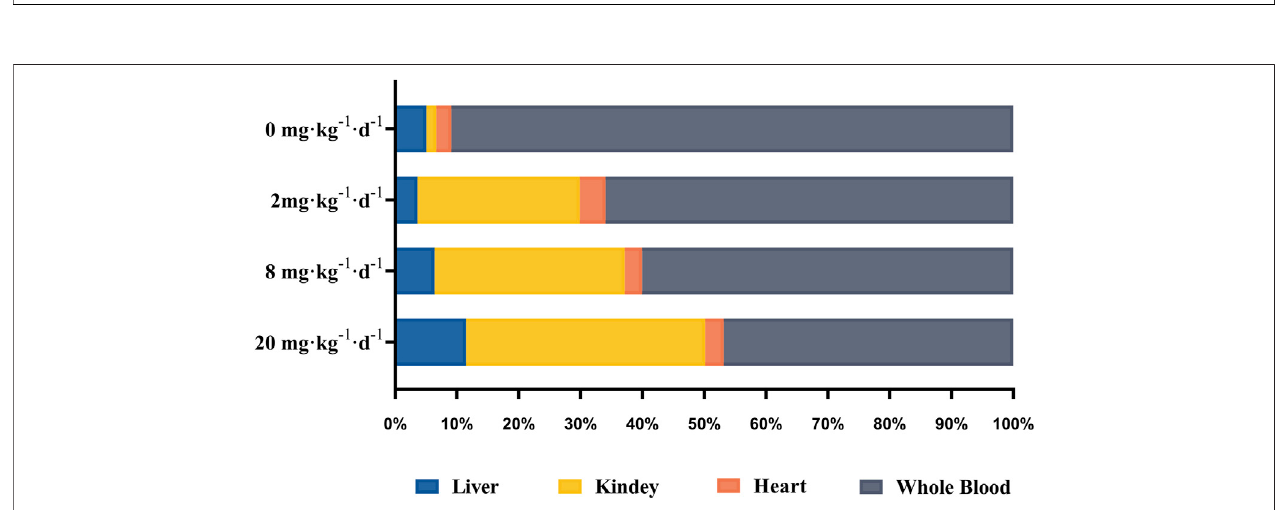
FIGURE 6 | The distribution of total arsenic in whole blood and tissue samples after intragastric administration of ATO for 28 days.